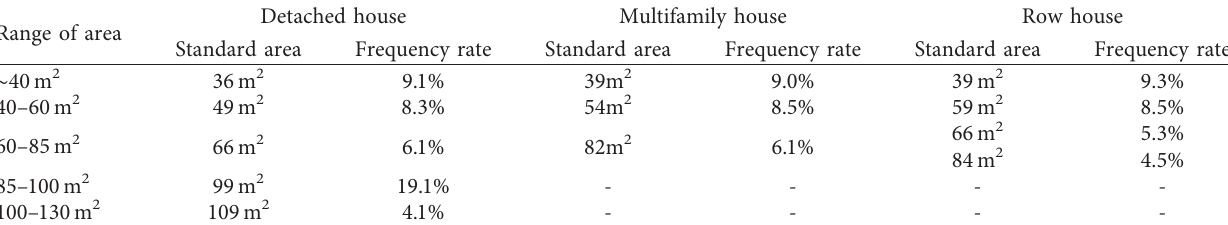
Table 4: Derivation of standard areas within the floor area range (Ministry of Land, Infrastructure and Transport, Korea).